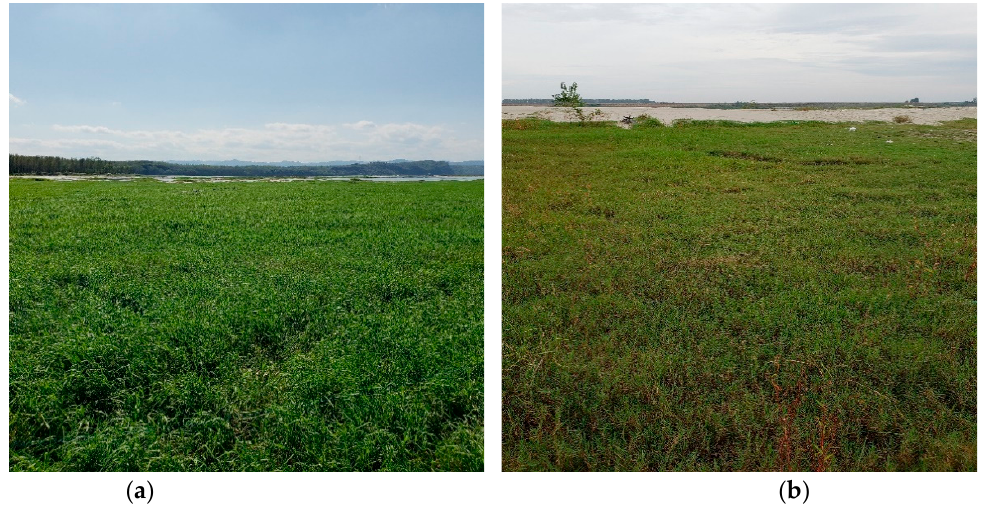
Figure 1. ( a ) Paspalum distichum community (the first transect of Shanbiancun (SBC), September 28, 2018); ( b ) Cynodon dactylon community (the second transect of Zekou (ZK), October 1, 2018).